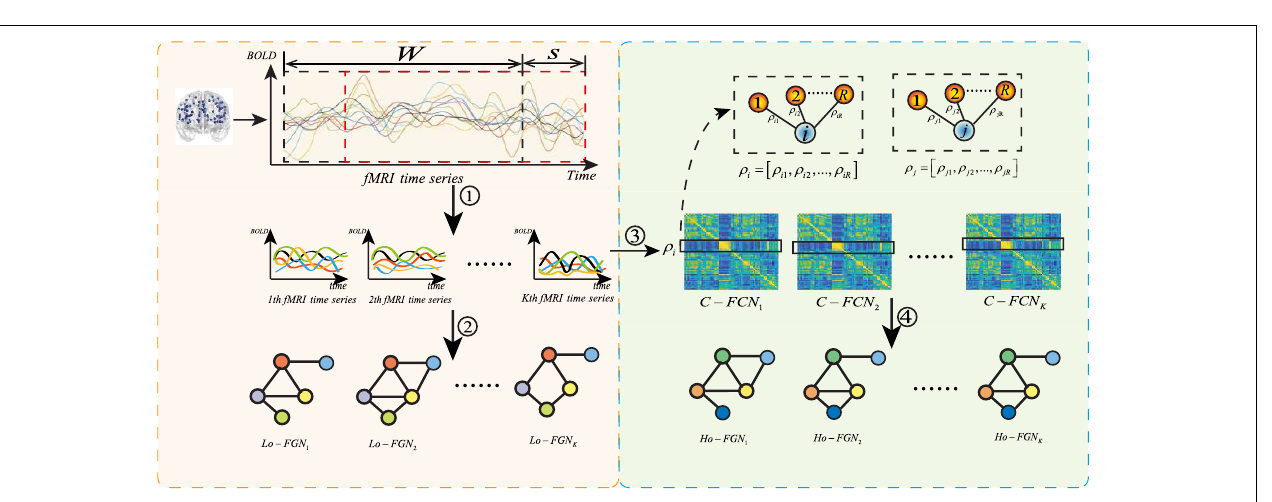
FIGURE 6 | Construction of multi-level function graph network, where (cid:192) represents get K sub fMRI time series; (cid:193) represents the construction of Lo-FGN from fMRI time series; (cid:194) represents the use of Pearson correlation to build a functional connectivity network (FCN); (cid:195) represents the construction of Ho-FGN from FCN. ρ i represents Pearson correlation between the i − th ROI and other ROIs. C − FCN i represents the i − th traditional functional connectivity